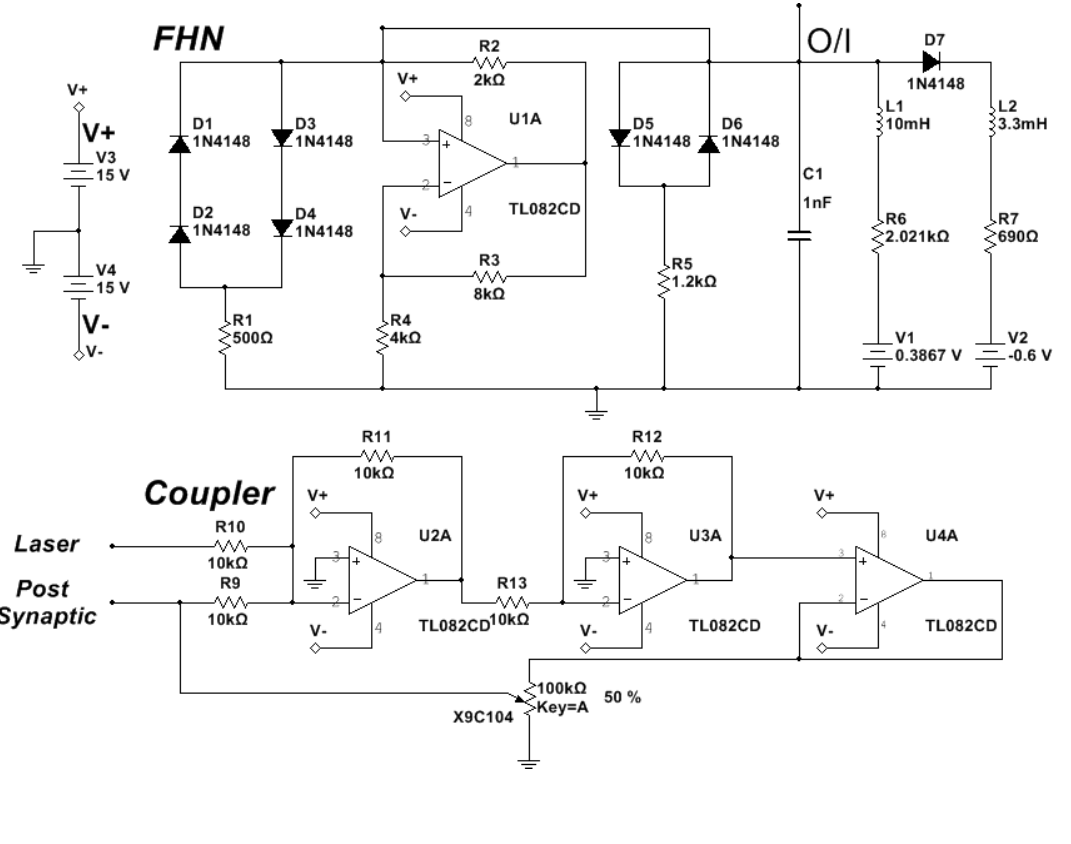
Figure 2. Electronic schemes of FitzHugh–Nagumo and coupler circuits.